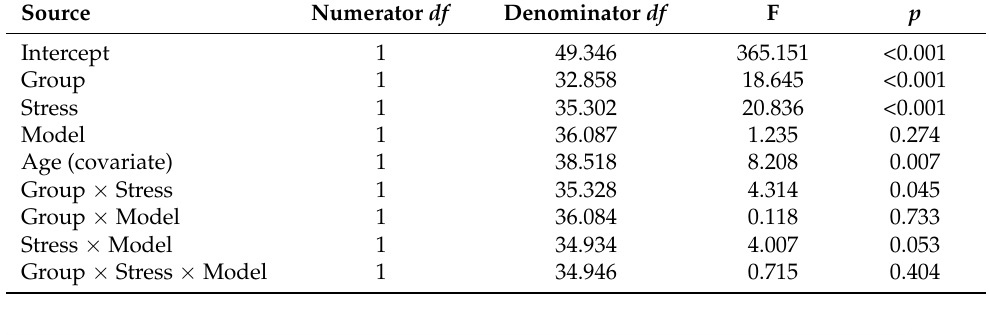
Table 3. Test of fixed effects exploring the influence of group (TD, CAS), stress type (SW, WS), and model (single, multiple) on tool–human percent agreement for lexical stress classification, accounting for the effect of the child’s age.